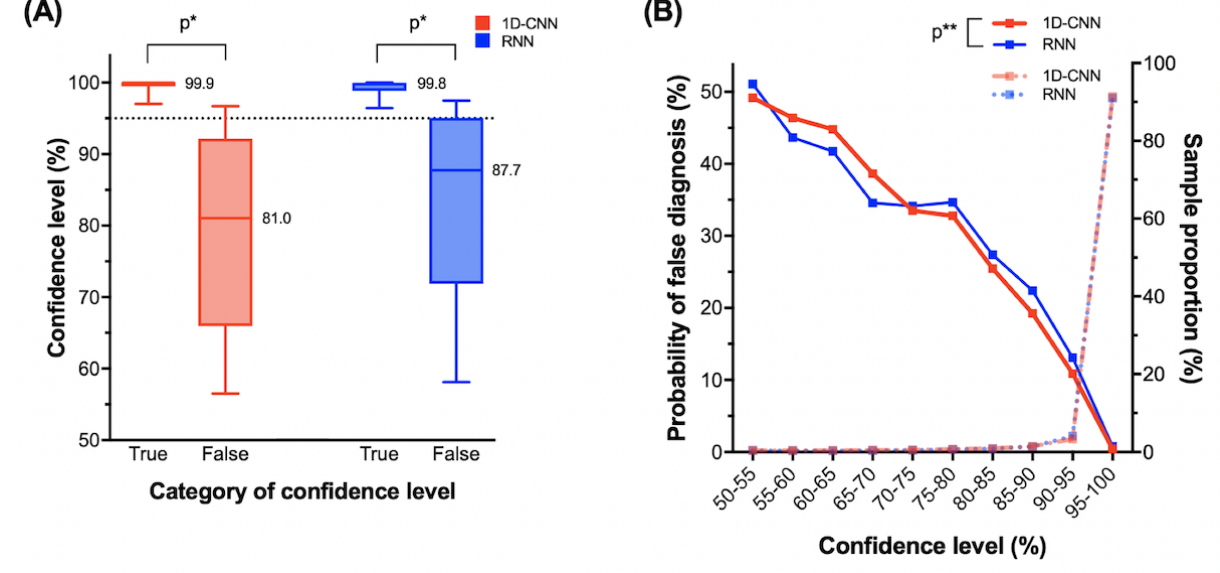
Figure 5. The characteristics of confidence level (CL) calculated by deep learning (DL) classifiers. Data were obtained by repeating the 5-fold cross-validation test over 10 times. (A) Comparison of true and false CLs of 1-dimensional convolutional neural network (1D-CNN) and recurrent neural network (RNN) methods by Box-and-Whiskers plot. True CLs indicate the cases where the diagnosis of a DL classifier was correct. Conversely, false CLs indicate cases where a DL classifier was incorrect. In the both 1D-CNN and RNN methods, the distributions of true or false CLs were significantly different ( P <.001) for both 1D-CNN and RNN methods. If cut-off level of CL is to be 95% (dashed line), the diagnostic accuracy was 99.6% in 1D-CNN and 99.2% in RNN. Therefore, a diagnosis with a CL ≥ 95% can be regarded as certain. (B) The association between the probability of misdiagnosis and sample proportions and the respective CLs. Because 91% of the tested samples showed CL ≥ 95%, most diagnoses made by DL classifiers were valid. The probability of false diagnoses decreases from 50% to 0% as the CL increases from 50% to 100%. Comparing 1D-CNN and RNN, there was no significant difference in CLs ( P =.98). * P <.001, calculated by Student t test. ** P =.98, calculated by Student t test.